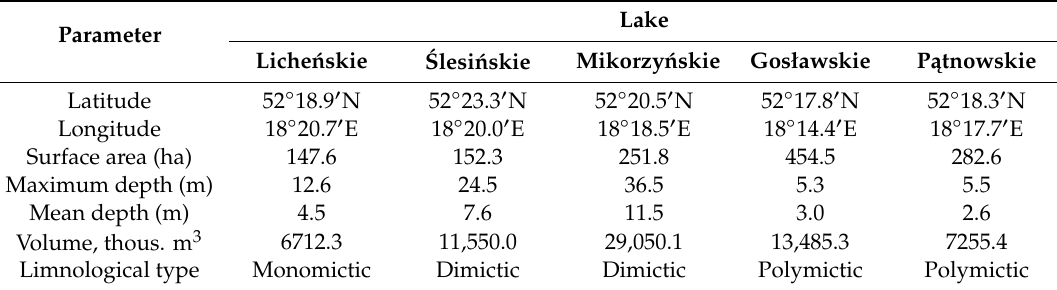
Table 1. Characteristics of the studied Konin lakes based on [22,24].